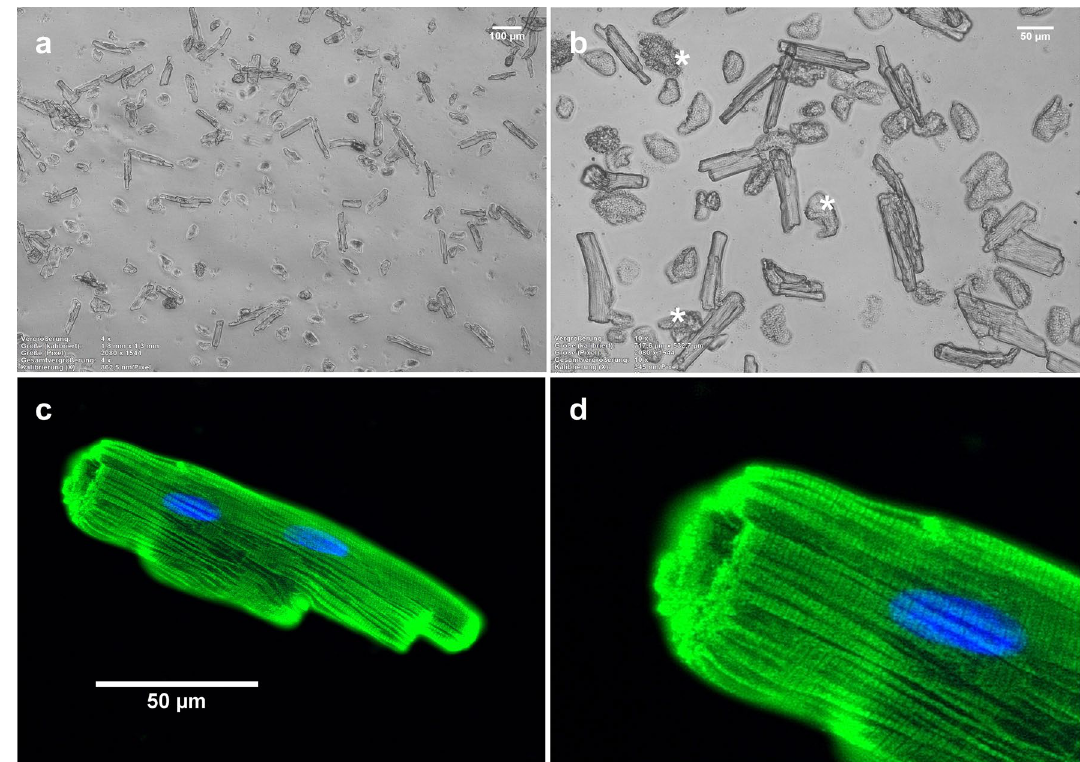
Figure 1. Primary cardiomyocytes harvested after a typical isolation process. ( a,b ) Bright-field microscopy showing a typical field of view on one coverslip with adhered cells in culture medium. In ( b ), as examples, three cells that do not meet the criteria to be considered viable are marked with an asterisk. ( c ) Fluorescence microscopy after α-MyHC immunostaining (green) and nuclear staining (blue, DAPI) confirmed structural integrity of a typical viable cardiomyocyte (adherent, rod like shaped and with clearly defined ends). ( d ) Magnification of the left-upper region of the cell showed in C. Note the characteristic striated pattern of cardiomyocytes. Images acquired and processed using Olympus cellSens (version 2.3) https:// www. olymp us- lifes cience. com/ de/ softw are/ cells ens/ and ImageJ (version 1.49.v) https:// imagej. nih. gov/ ij/ software